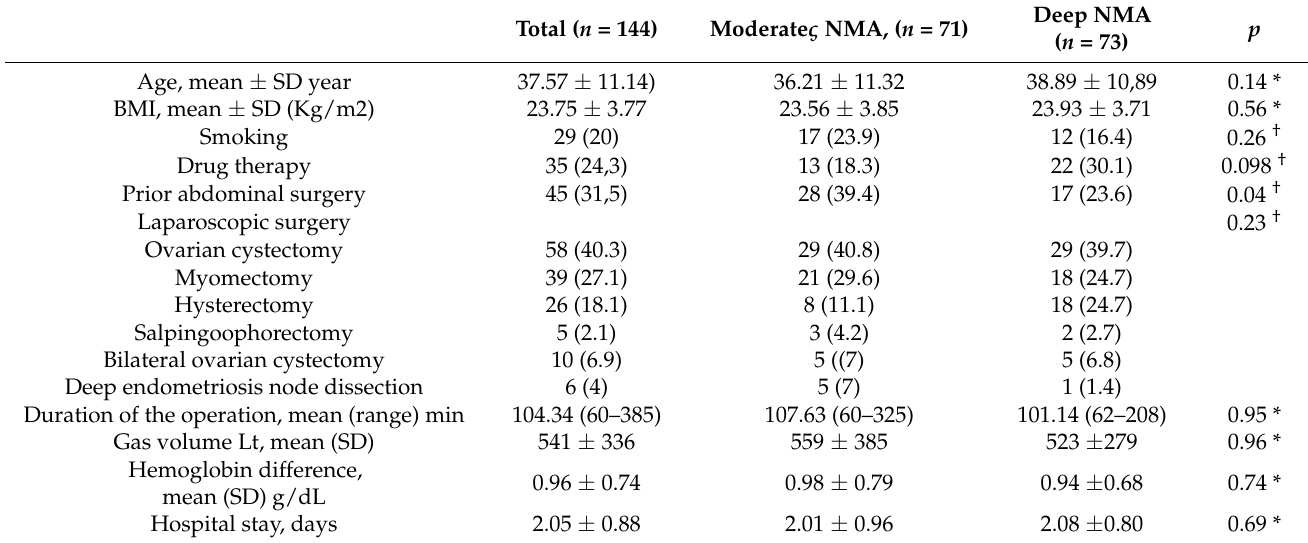
Figure 1. CONSORT flow chart .